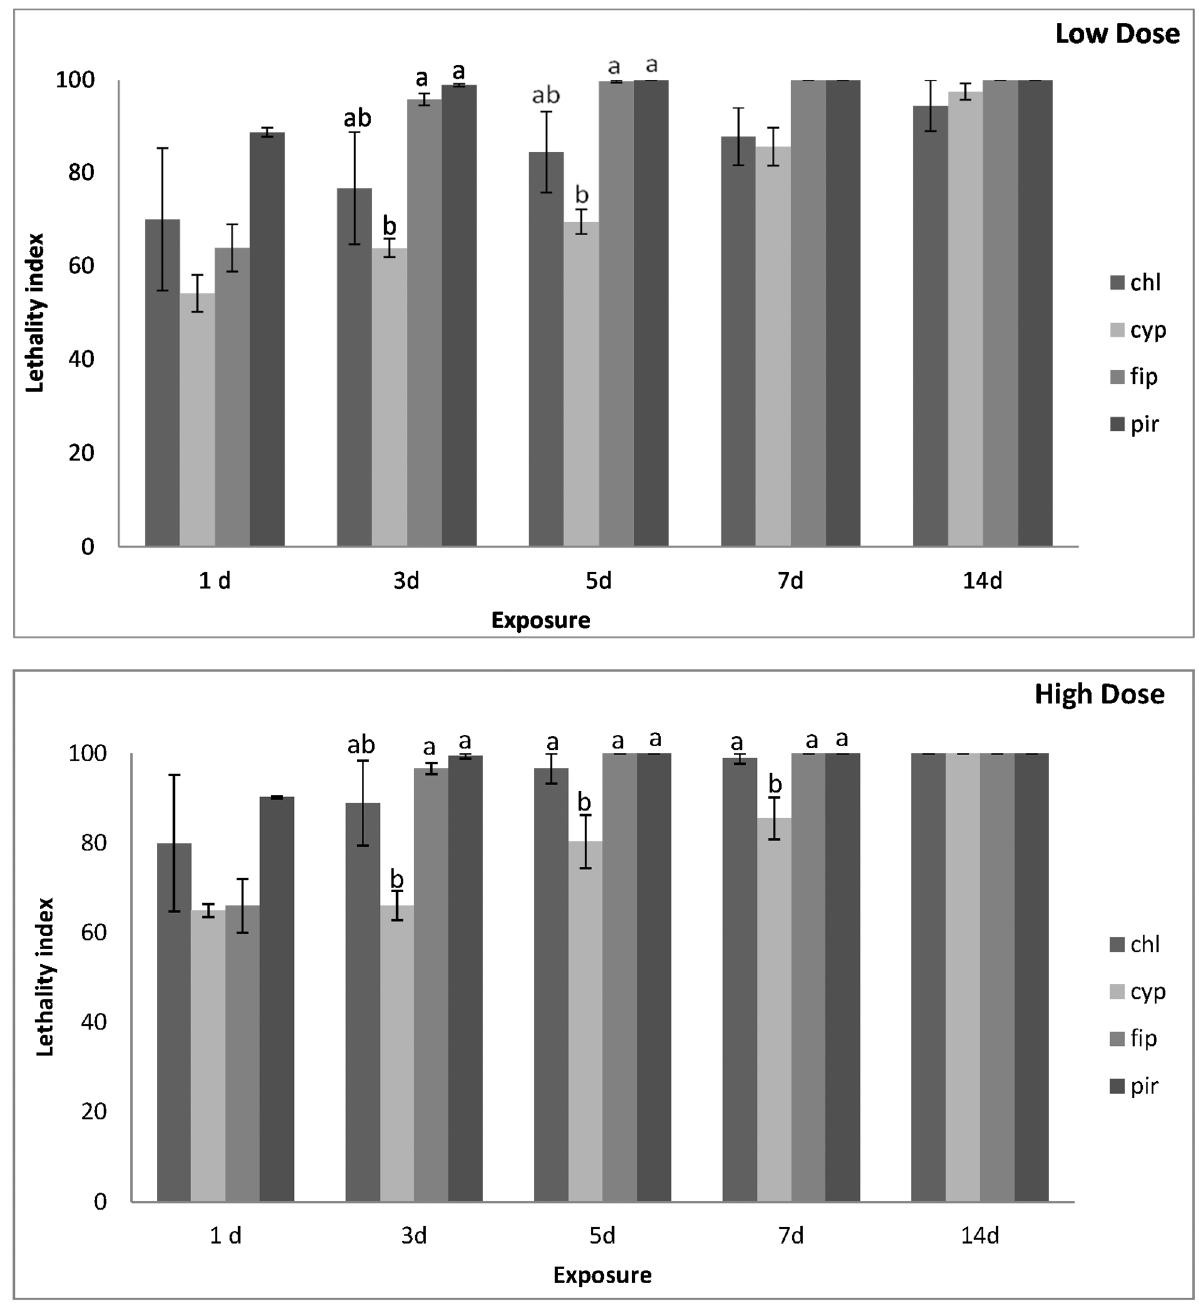
Fig 6. Lethality index of T . confusum adults on metal surfaces at low and high dose. Mean lethality index ( ± SE) of T . confusum adults on metal treated with chlorfenapyr (chl), alpha-cypermethrin (cyp), fipronil (fip) and pirimiphos-methyl (pir), at the low and the high dose rate of each insecticide after 1, 3, 5, 7 and 14 d of